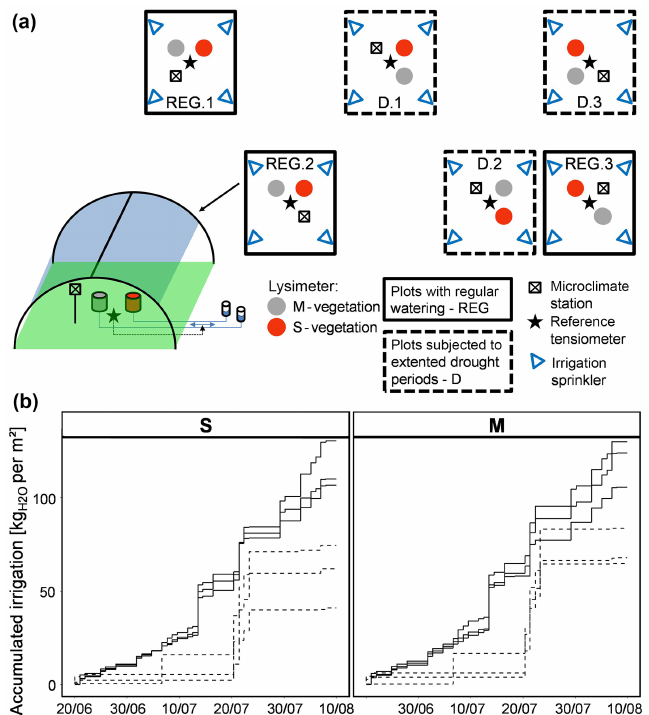
Figure 1. (a) Schematic overview of the experimental design and plot setup; (b) manipulation of water availability for individual lysimeters of the two vegetation types (Stubai (S) and Matsch/Mazia (M)) by contrasting irrigation schemes – one providing water on a regular basis (REG, solid lines), one with extended drought periods (D, dashed